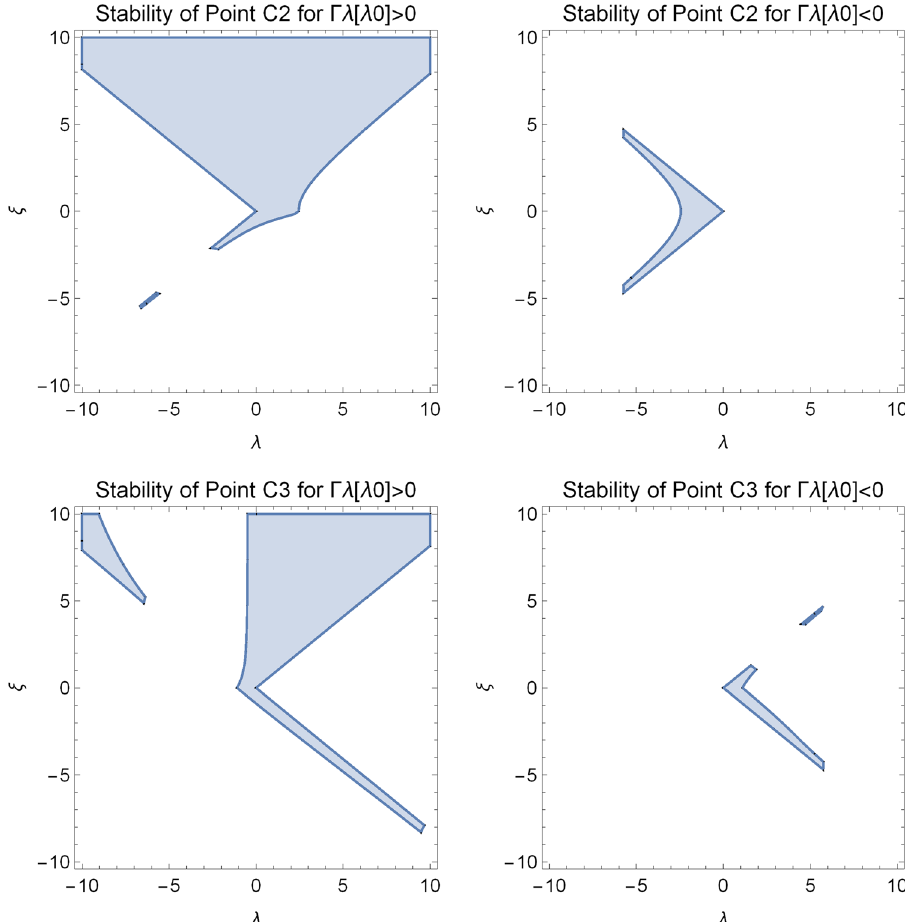
Fig. 3 Region plots for the variables { λ 0 ,ξ (λ 0 ) } in which points C 2 and C 3 have eigenvalues with negative